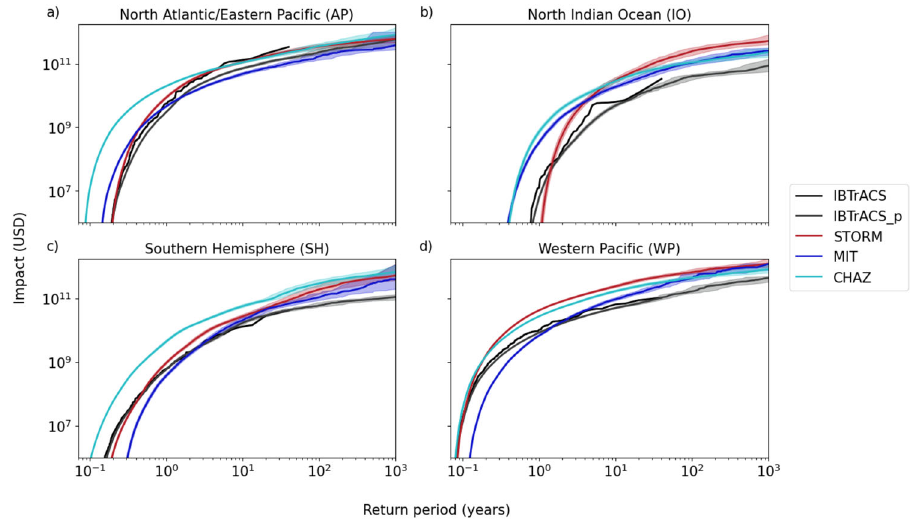
Fig. 2 | Impact return period curves for the fi ve tropical cyclone track sets. Return periods up to 1000 years for the synthetic track sets (IBTrACS_p, STORM, MIT, CHAZ) and 39 years for the IBTrACS record (black solid curve) are shown in the fourregions a North Atlantic/EasternPaci fi c, b NorthIndian Ocean, c Southern